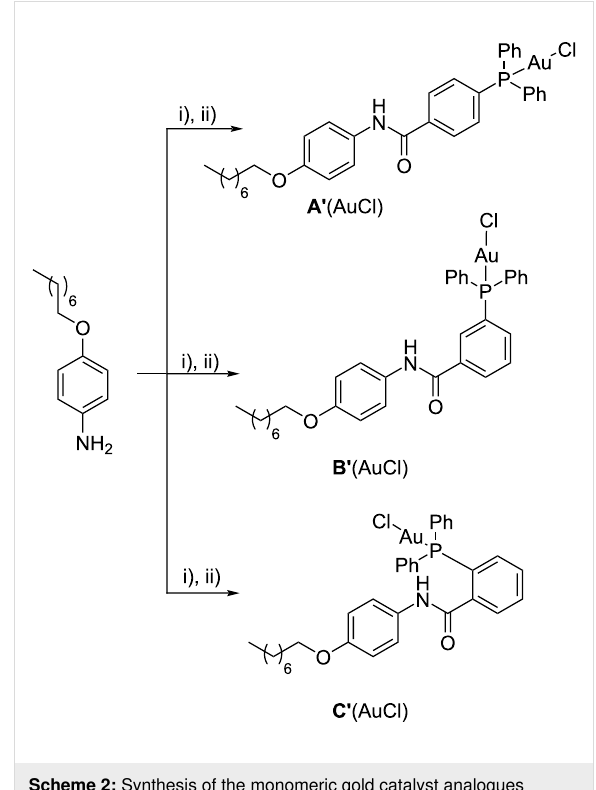
Scheme 2: Synthesis of the monomeric gold catalyst analogues A’ , B’ , C’ (AuCl). Conditions: i) diphenylphosphinobenzoic